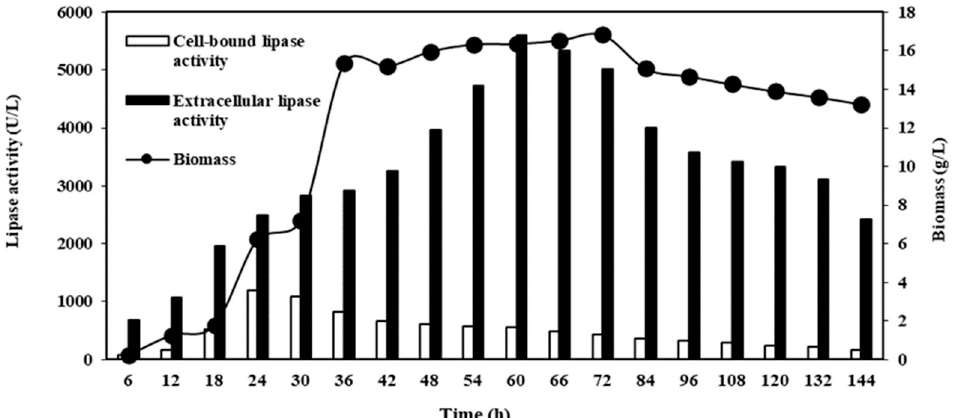
Figure 7. Time courses of CBL, and extracellular lipase, and biomass production from M. spicifer SPB2 in a 5-L stirred-tank bioreactor with the IMY medium containing 2% soybean oil and 0.2% Gum Arabic, using an inoculum level of 1 × 10 7 cell/mL at 30 ± 2 °C under an aeration rate of 0.75 vvm and a stirring speed of 400